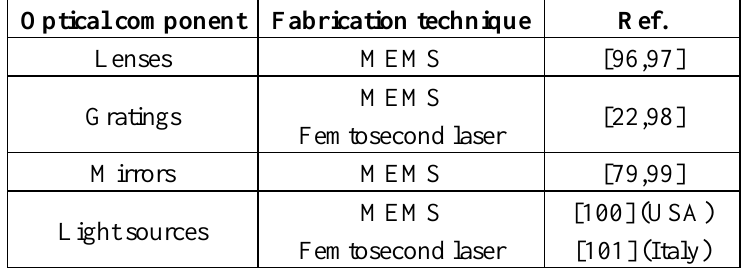
Table 5. Micro-optical components integrated in opto-microfluidic